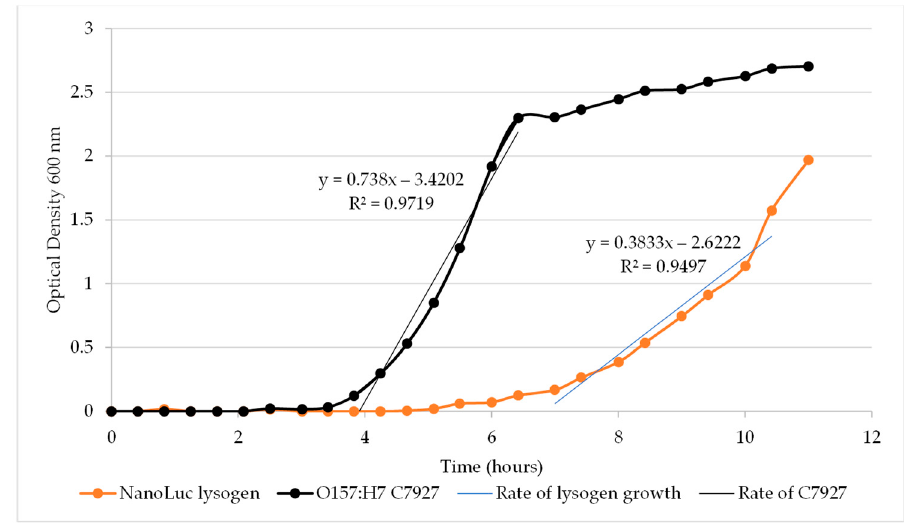
Figure 2. Growth of E. coli O157:H7 C7927 and C7927 Φ V10 nluc lysogen at 37 °C.